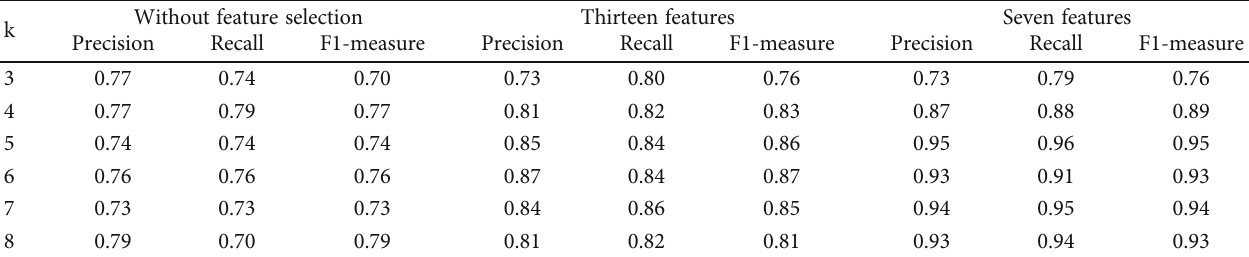
Table 2: Comparison of results for experiment 1 with di ff erent numbers of clusters ( k ).